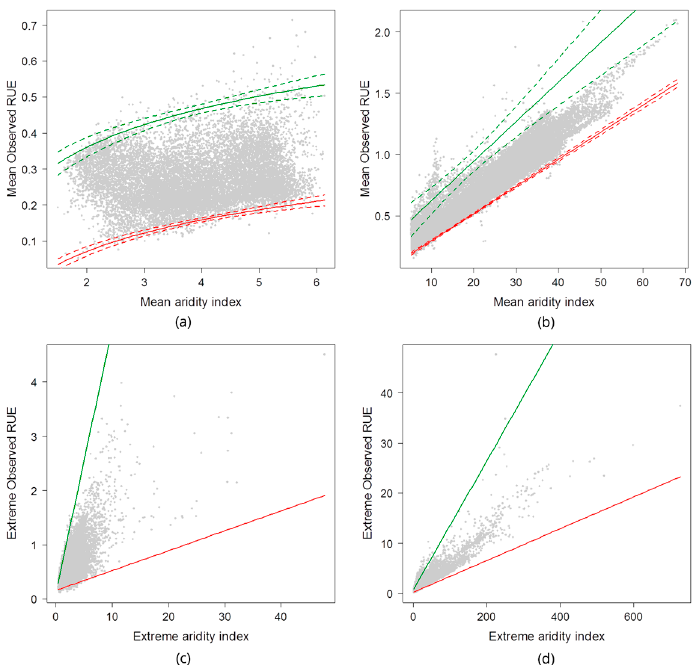
Figure 2. Observed Rain Use Efficiency (RUE) in NW Maghreb (1998–2008) plotted against aridity (PET/P): ( a ) between-year mean observed RUE for the full period, wet to semi-arid classes; ( b ) between-year mean observed RUE for the full period, arid class; ( c ) extreme observed RUE for the six-month period preceding the month with maximum vegetation density, wet to semi-arid classes; ( d ) extreme observed RUE for the six-month period preceding the month with maximum vegetation density, arid class. Empirical boundary functions fitted to the 1st and 99th percentiles of the scatterplots define the potential limits of expected RUE for any aridity level. For mean observed RUE, reference (99th percentile) and baseline (1st percentile) RUE performance are within the respective 95% confidence interval.